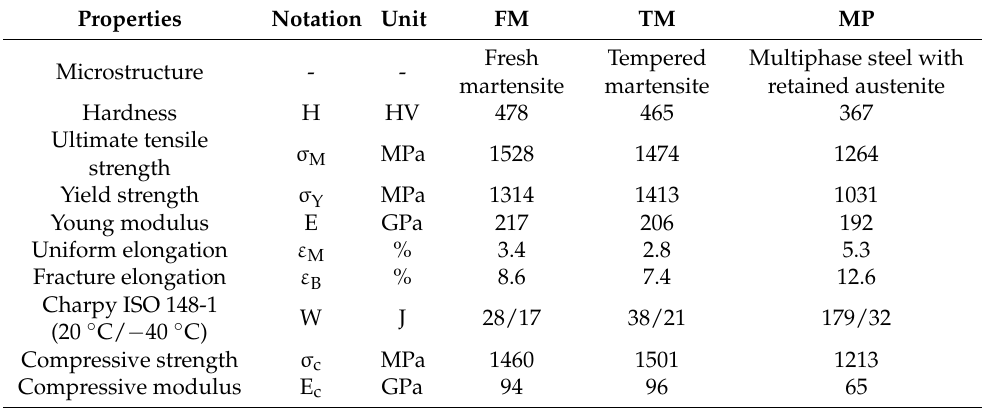
Table 2. Properties of the tested